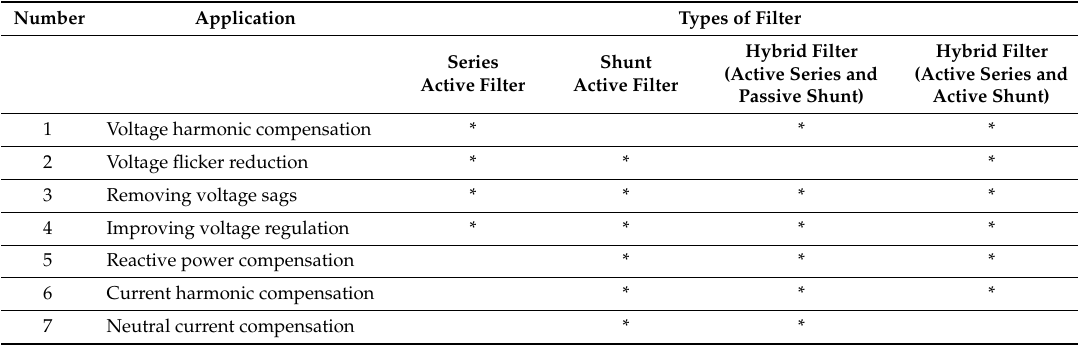
Table 5. Selection of shunt and hybrid APFs for specific applications.